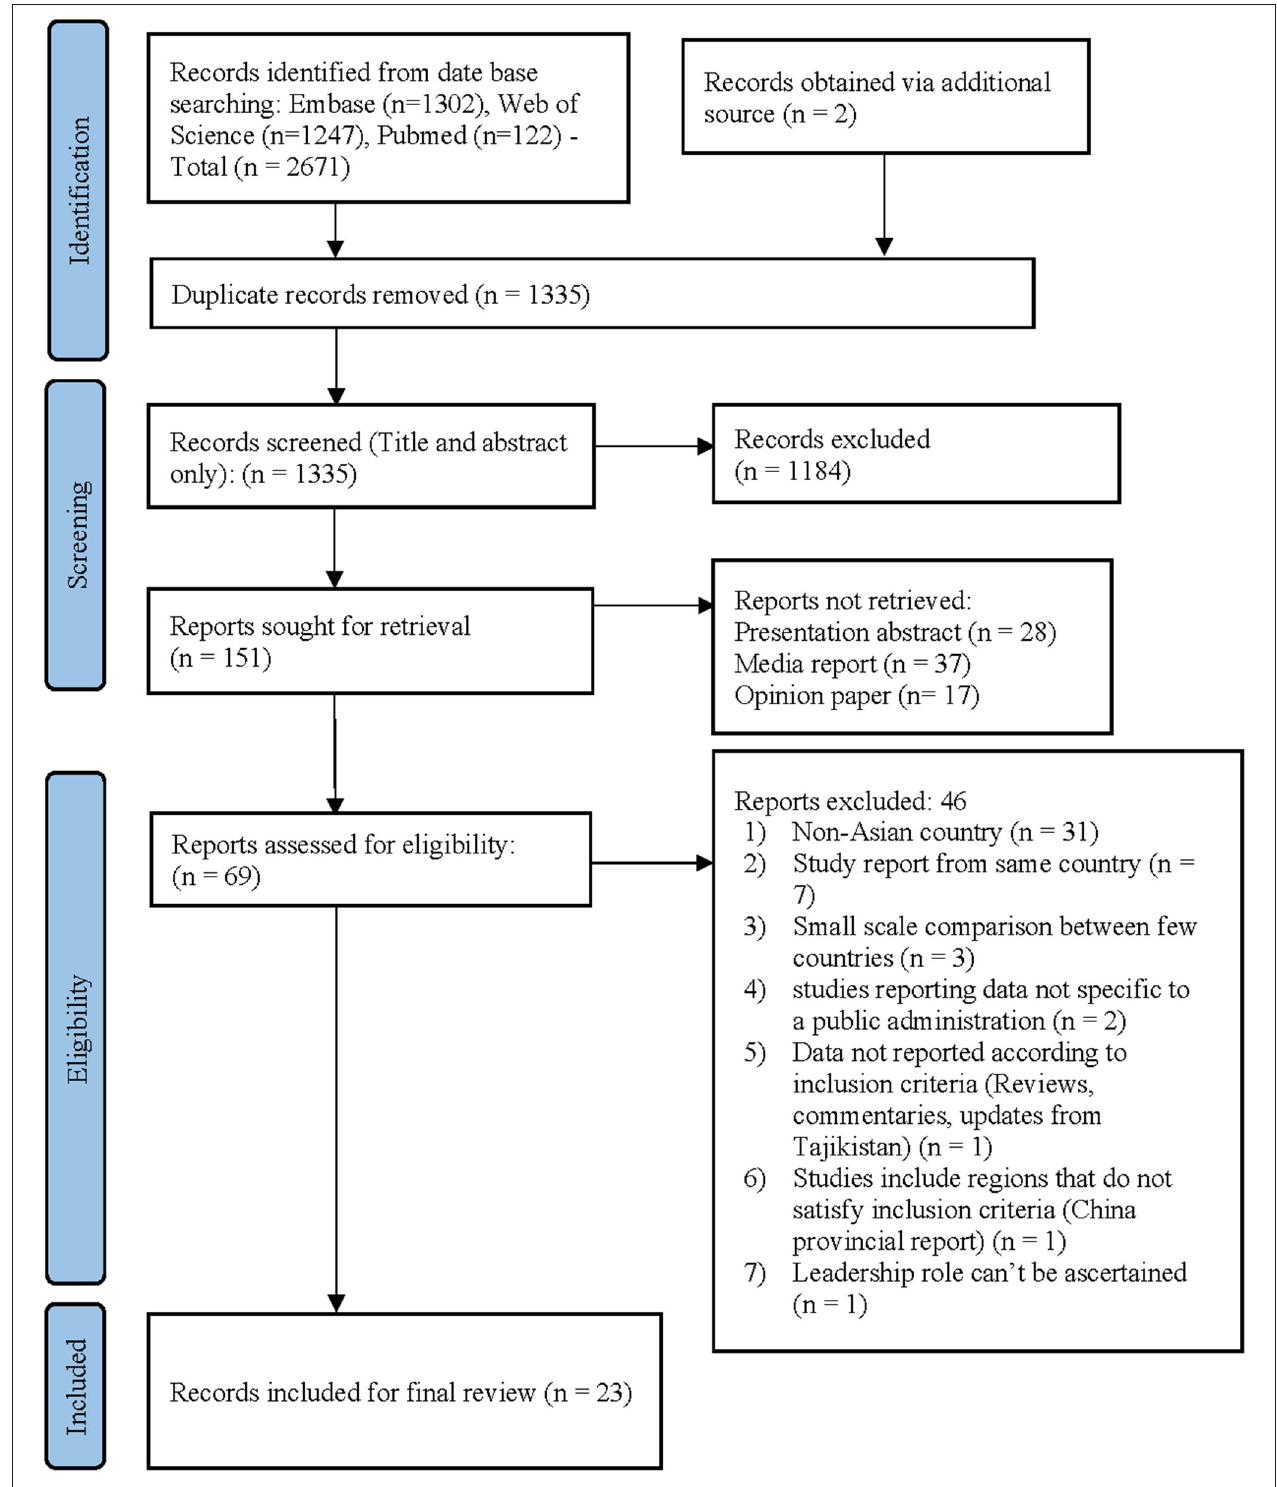
FIGURE 1 | PRISMA Flow diagram. PRISMA chart illustrating our process of obtaining the 23 included articles.